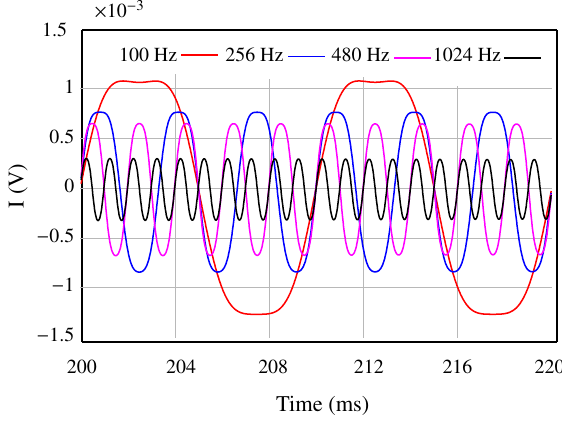
Figure 18. Magnitude of the IF signals (in-phase